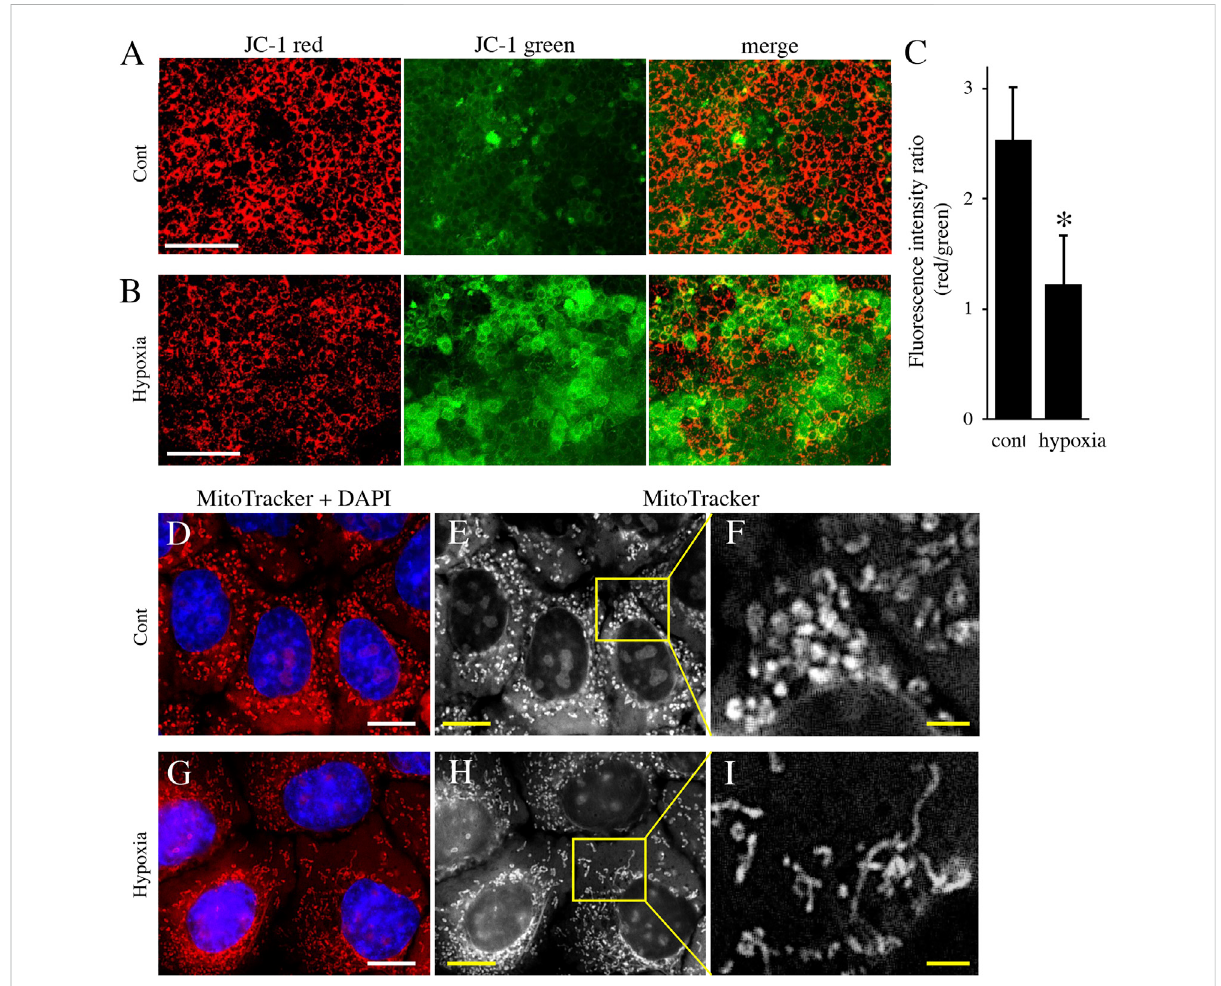
FIGURE 5 The effect of environmental hypoxia on mitochondrialmembrane potential and morphology in HAT7 cells. (A,B) HAT7 cells cultured in hypoxia display adecrease inmitochondrialmembranepotential isevidentbythelack ofred JC-1aggregate (red) accumulation and higher staining for JC-1 green monomers. (C) Quanti fi cation of red/green JC-1 staining indicative of membrane potential. n = 3. MitoTracker Orange CMXRos staining of HAT7 cells cultured in normoxia (D – F) and hypoxia (G – I) for 48 h. The boxed area in (E,H) are magni fi ed in (F,J) , respectively. The nucleus is stained with DAPI (blue). Data are represented as their mean ± SD. * p < 0.05 (unpaired two-tailed Student ’ s t -test). Scale bars, 100 μ m (A,B) ; 10 μ m (D,E,G,H) ; 2 μ m (F – I)